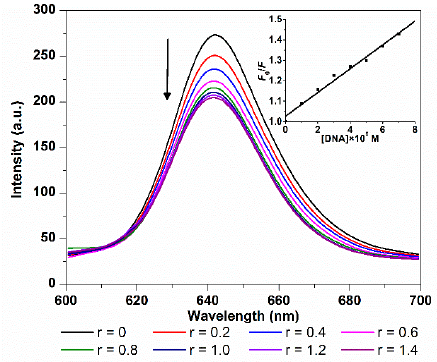
Figure 2. Fluorescence spectra changes of TCPC (5 μ M) on the titration of increasing amounts of ct-DNA( r = [DNA]/[TCPC]) in Buffer I ( λ ex = 420 nm); the inset is the plot of F 0 / F vs. [DNA].